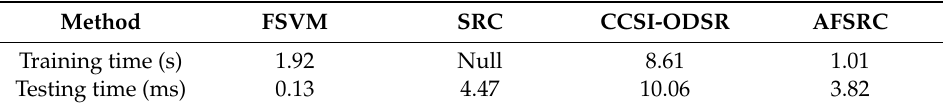
Table 6. Training/testing time of different